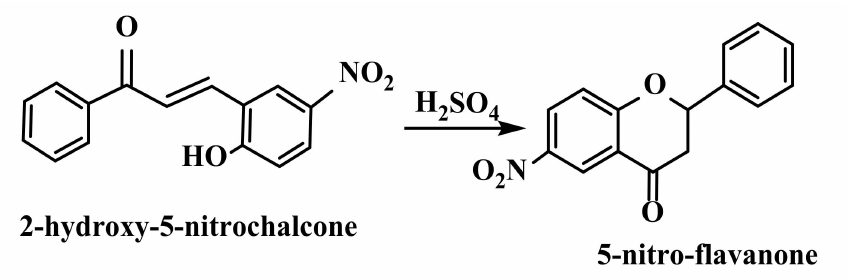
Figure 4. Cyclization of 2-hydroxy-chalcone to flavanones